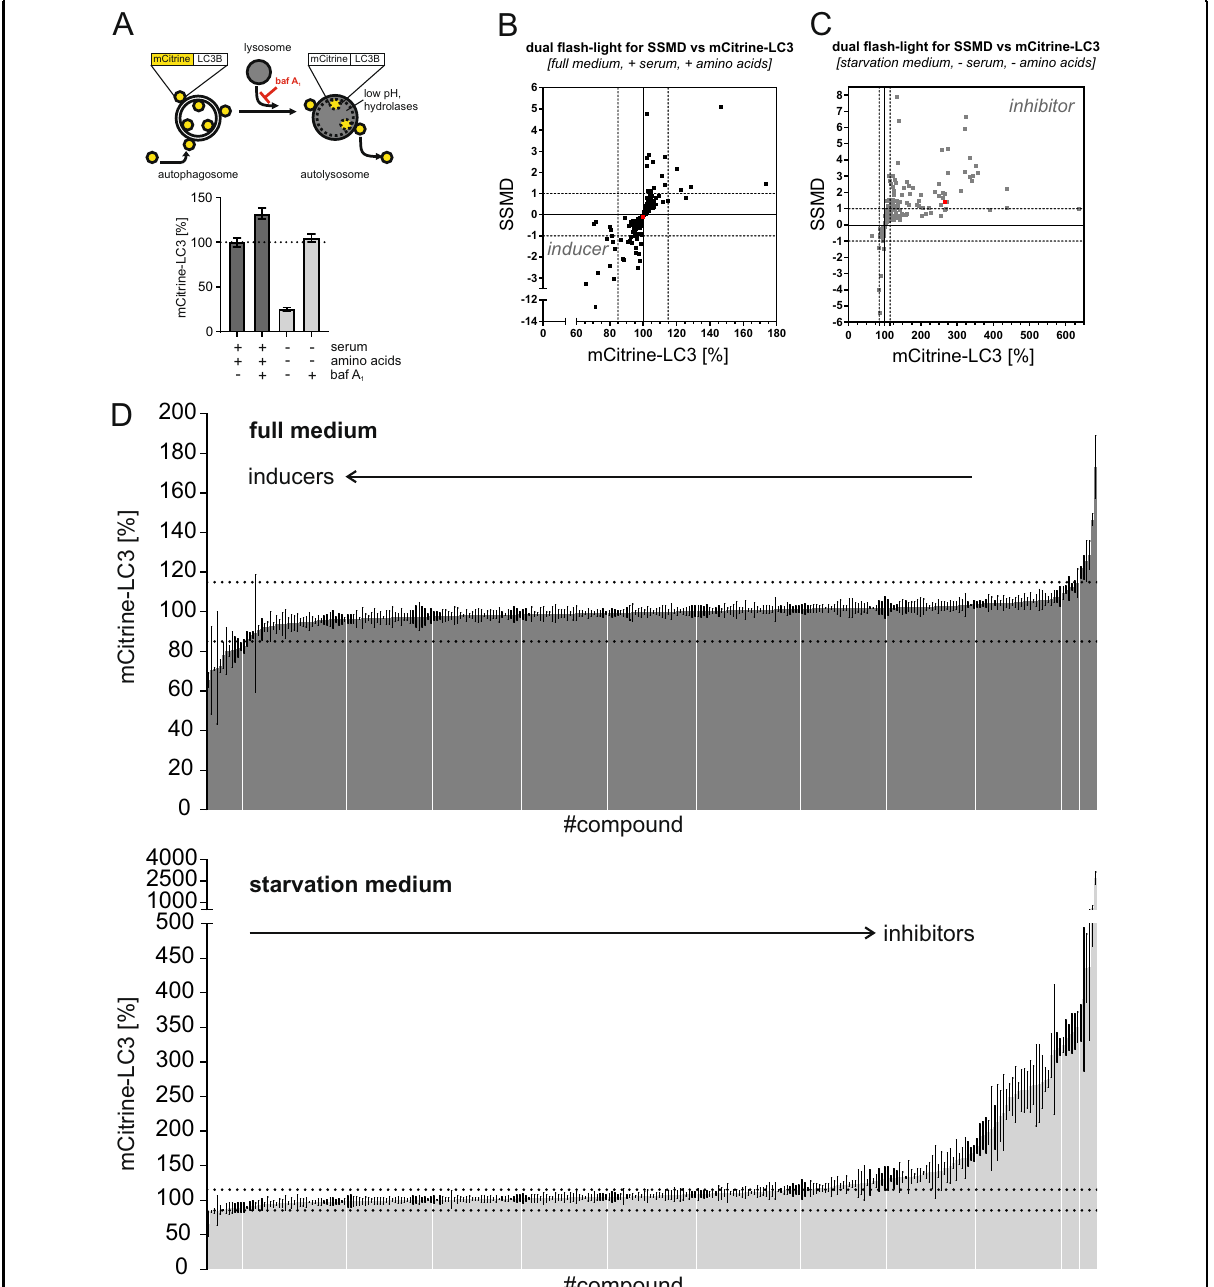
Fig. 1 High-throughput screening for natural compound-based autophagy modulators. A Detection of starvation-induced and ba fi lomycin A 1 -inhibited autophagy in a fl ow cytometric screening. MEFs stably expressing mCitrine-LC3 were cultured either in full medium plus serum or in starvation medium and were treated with either 10 nM ba fi lomycin A 1 or mock treatment (DMSO) for 6 h ( n ≥ 19). The mCitrine fl uorescence is shown as a percentage relative to that of mock-treated cells. Data represent means ± SEM. B , C High-throughput autophagy screening of 300 natural compounds. The diagram shows dual- fl ashlight plots for strictly standardized mean difference (SSMD) versus the average percentage of mCitrine- LC3. Dotted lines de fi ne potential inducers and inhibitors of autophagy. Cells were treated with 10 µM of each compound for 6 h ( n = 3). Arzanol is highlighted in red. D The diagram shows individual levels of mCitrine-LC3 fl uorescence from ( B , C ) for each of the 300 compounds in full or starvation medium. Dotted lines mark the ±15% difference in mCitrine-LC3 levels. Data represent means ±